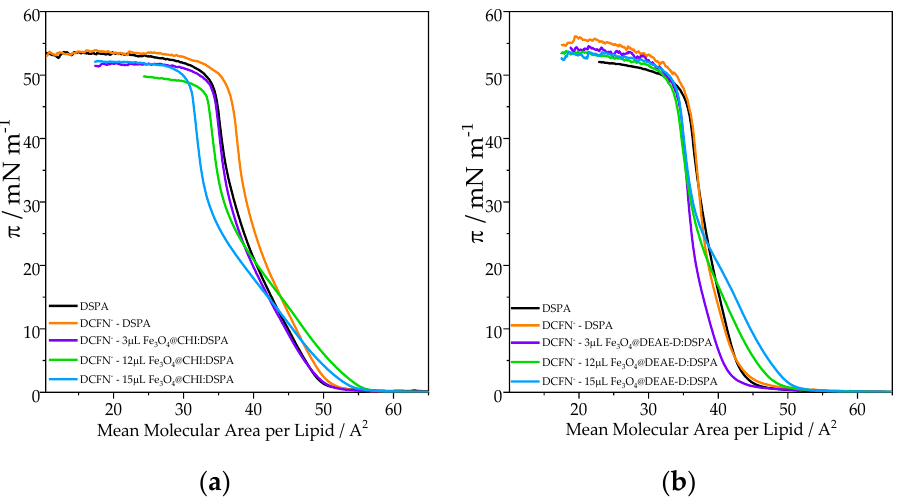
Figure 3. Surface pressure as a function of mean molecular area per lipid for the mixtures: ( a ) Fe 3 O 4 @CHI:DSPA (x µL: 50) and ( b ) Fe 3 O 4 @DEAE-D:DSPA (x µL: 50). Subphase composition: DCFN − 0.01 mM in LiCl 10 mM and LiCl 10 mM for black line.